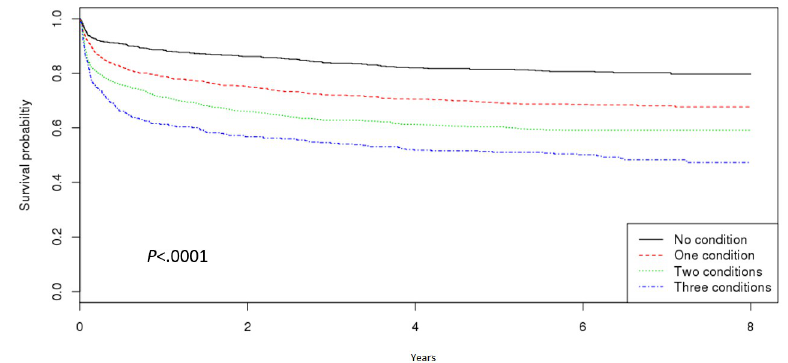
Fig 2. Survival curves by the number of metabolic comorbidities on